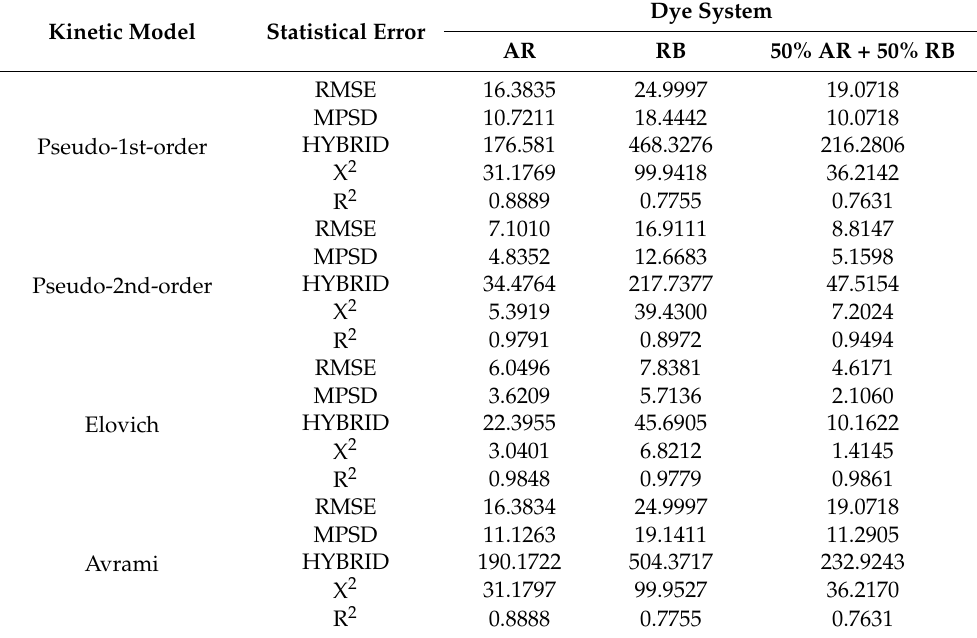
Table 4. Statistical error function values of kinetic nonlinear